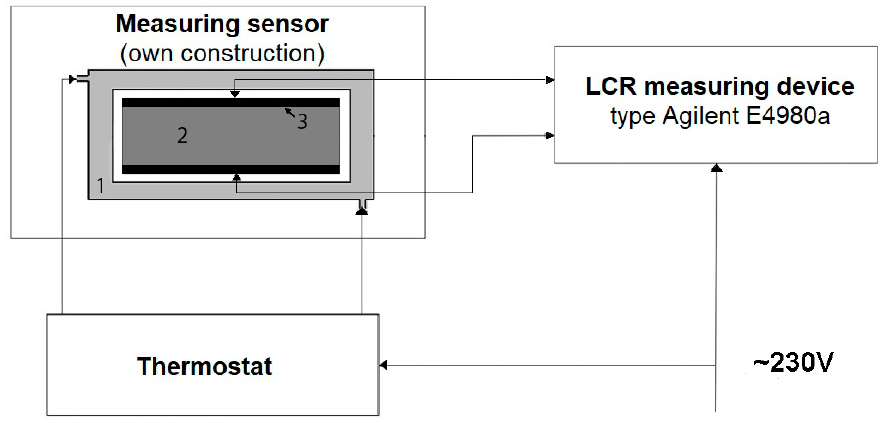
Figure 1. Diagram of the measurement system for testing electrical properties of engine oil. (1)—water jacket; (2)—sample; (3)—glass container with electrodes (measuring cell).